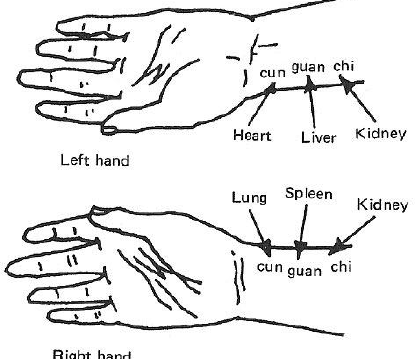
Figure 1. Different spots of radial artery on the wrist of the left and right hands represent different human organ in traditional Chinese pulse